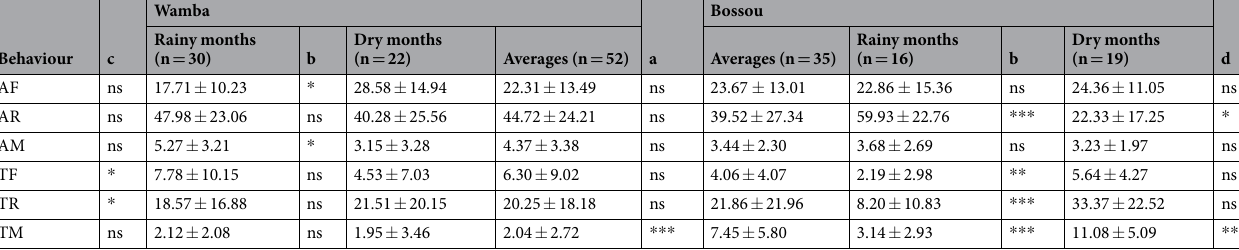
Table 1. Averages in activity budgets (% ± S.D.) stratified by research site and season. a p values by two-tailed Wilcoxon rank sum test between research sites. b p values between two seasons within a research site. c p values for rainy months between research sites. d p values for dry months between research sites. * p < 0.05, ** p < 0.01 *** p < 0.001.